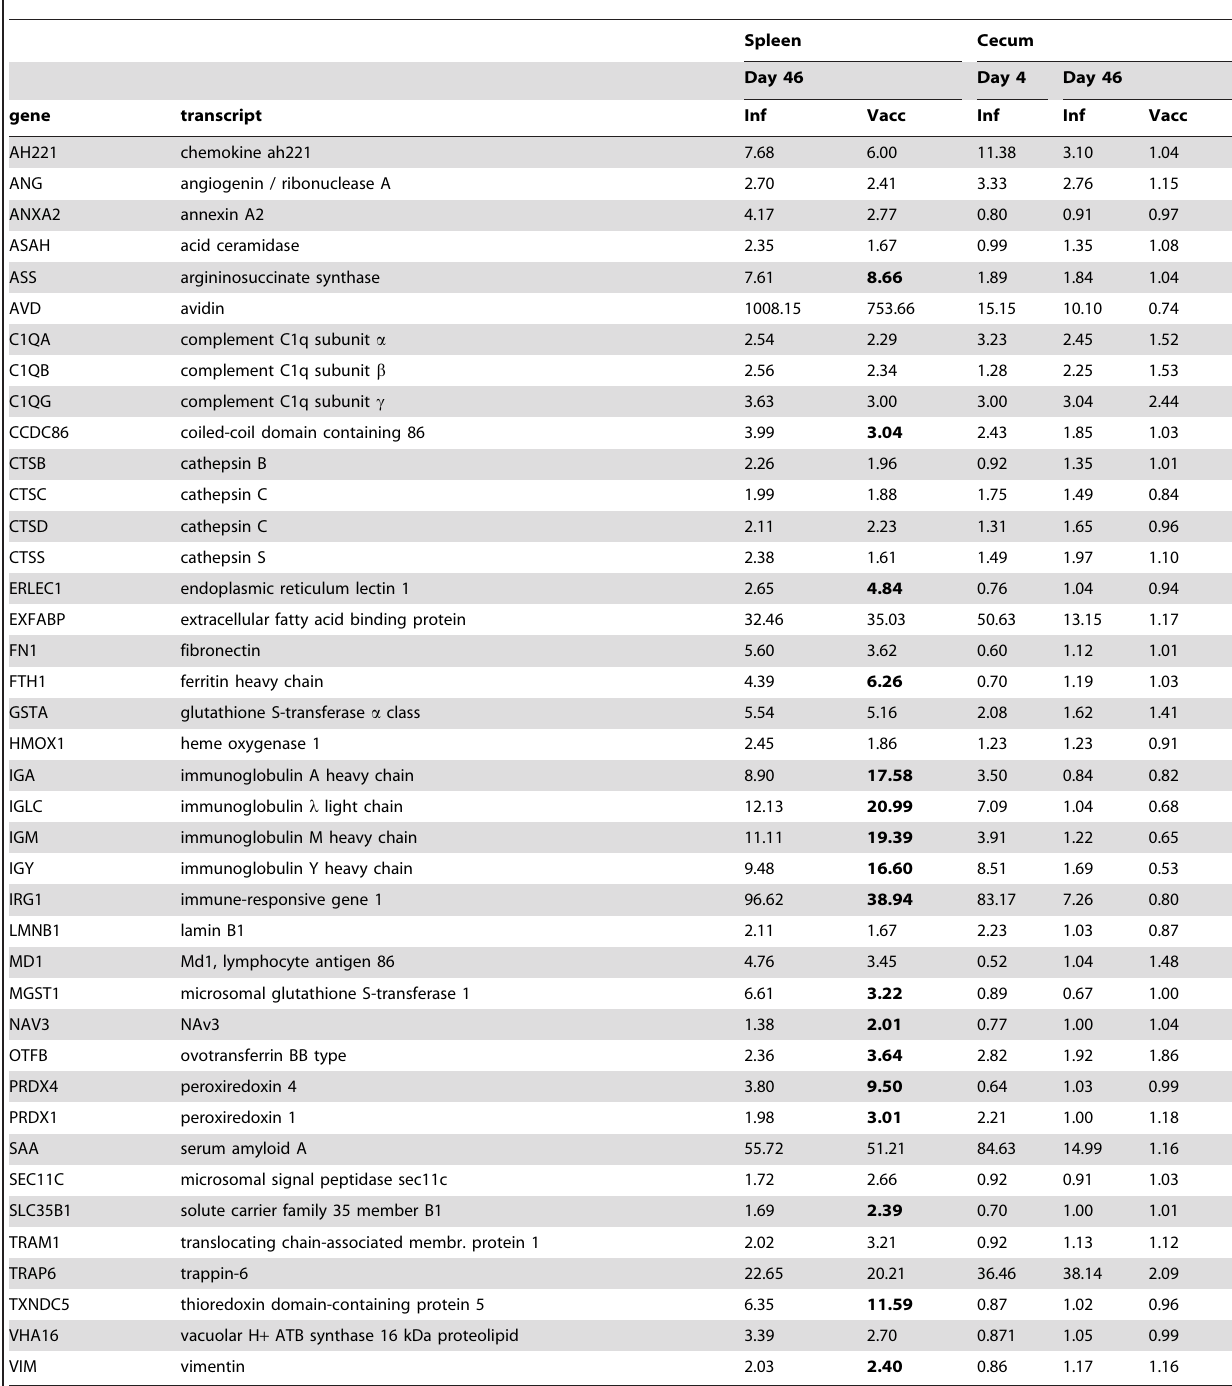
Table 1. Fold increase in gene expression in chickens after S . Enteritidis infection determined by real-time PCR.